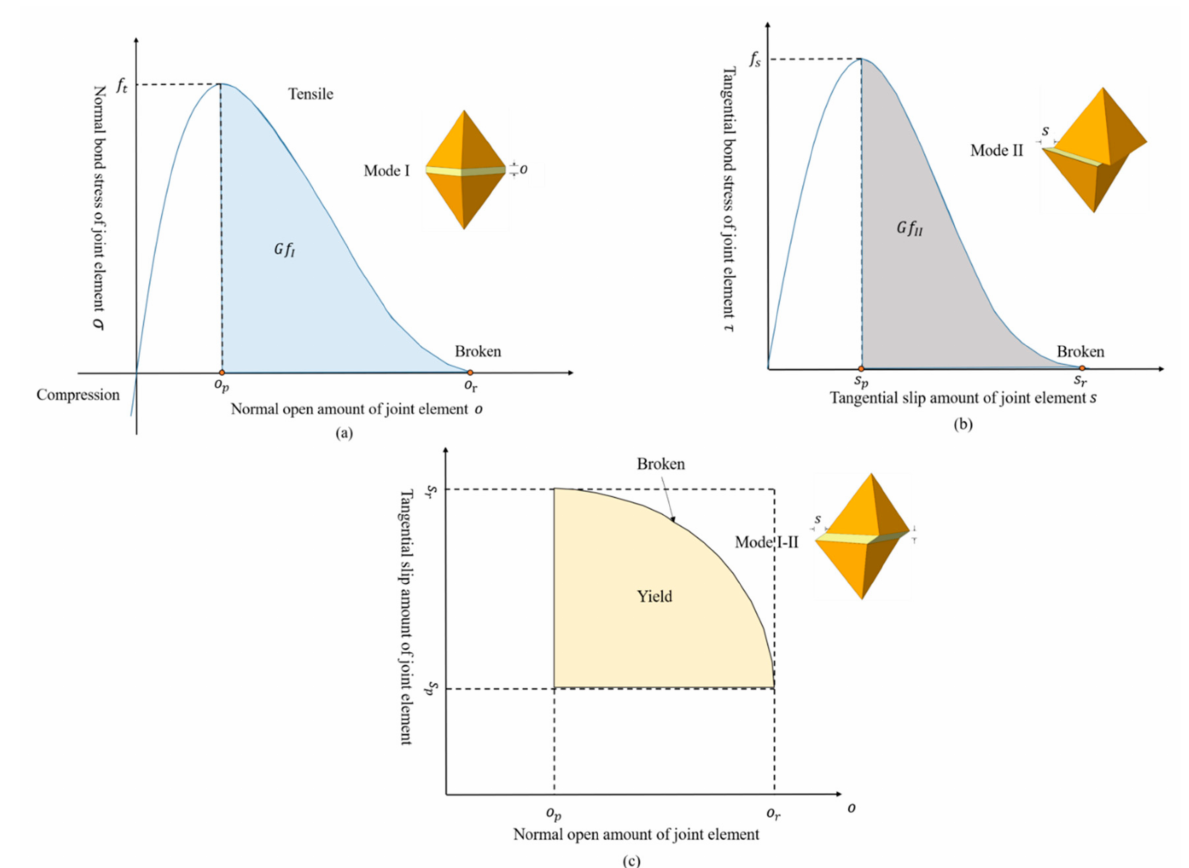
Figure 2. Fracture constitutive model of joint elements: ( a ) tensile failure; ( b ) shear failure; ( c ) mixed tensile and shear failure